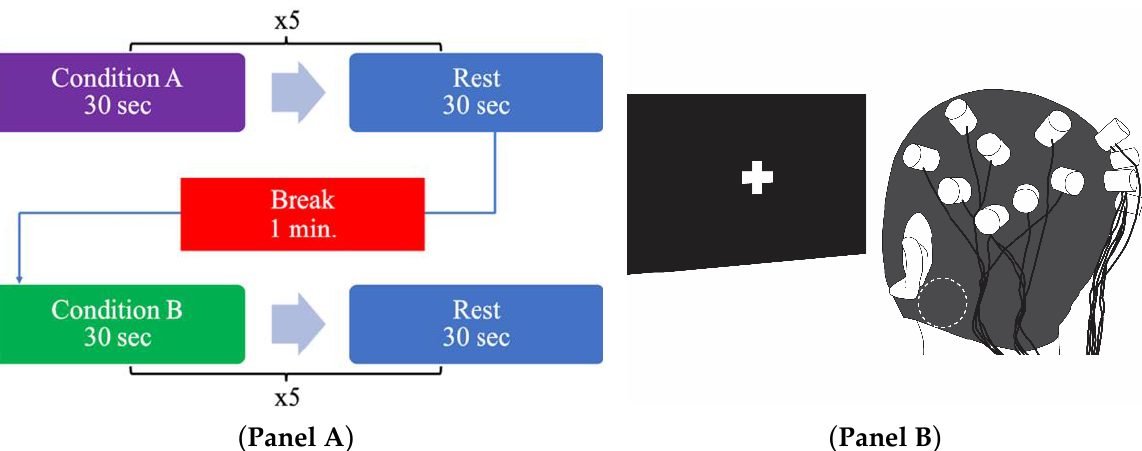
Figure 2. Panel A: Experimental design. Participants were randomized to start with nGVS or sham stimulation. After completing 5 repetitions of Condition A and Rest, participants took a 1-min break before completing 5 repetitions of Condition B and Rest. Panel B: Experimental setup. Participants wore fNIRS cap and focused on a crosshair while receiving nGVS or sham stimulation. Dotted circle indicates approximate location of stimulating electrode.